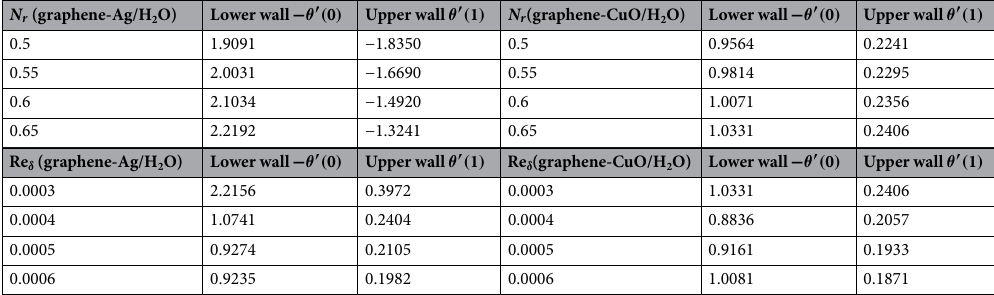
Table 3. Nusselt number numerical values for radiation parameter N r and Reynolds number Re δ .